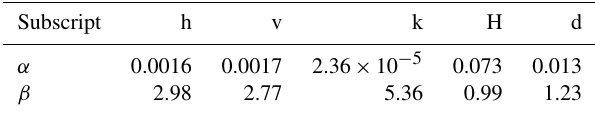
Table 1. Values of the coefficients α and β . α h , v , k and β h , v , k in Eqs. (9) and (10) and α H , d in Eqs. (17) and (18) are from Kawabata et al. (2018), and β H , d in Eqs. (17) and (18) is from Bringi and Chandrasekar